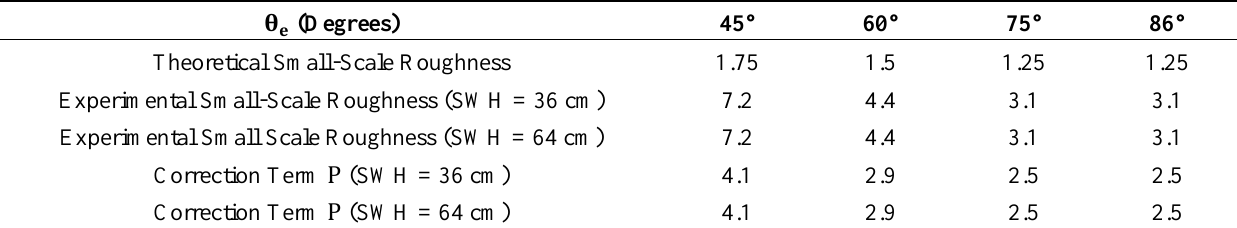
Table 5. Theoretical and experimental small-scale roughness values and correction term for SWH = 36 cm and 64 cm for θ = 45°, 60°, 75° and e